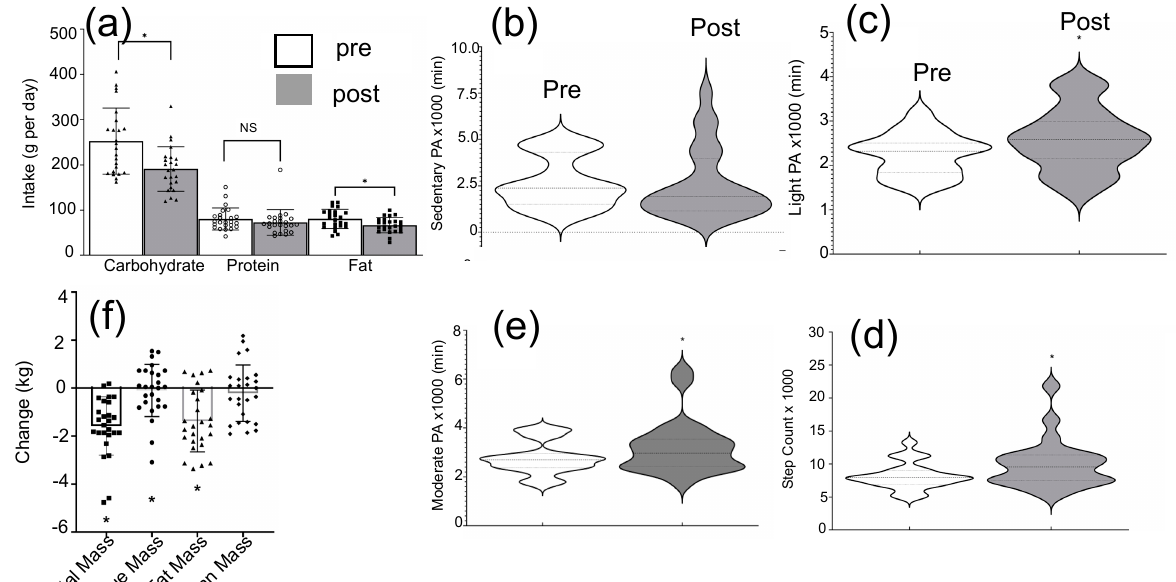
Figure 3. Results from diet and exercise intervention. In addition to blood sample collection, other important physiological properties were measured during the intervention. Additional physiological values were calculated and utilized to understand the meaning of miR results; ( a ) macronutrient intake (g per day). * p < 0.05, NS = non-significant. Physical activity (PA) compliance; ( b ) sedentary PA; ( c ) light PA; ( d ) moderate PA; ( e ) step counts. Note- no participants met thresholds for vigorous PA. * p < 0.05; and ( f ) variations of total, tissue, fat and lean masses of the subjects before and after the diet and exercise intervention * p < 0.05.